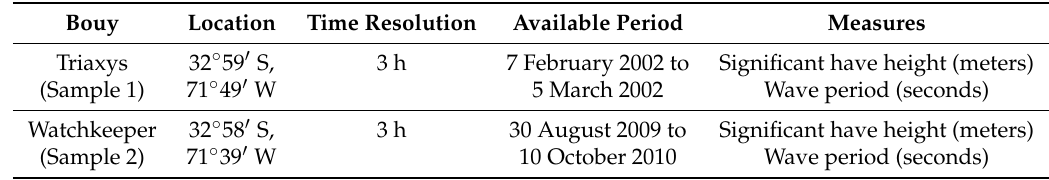
Figure 1. Buoys location. Table 1. Data